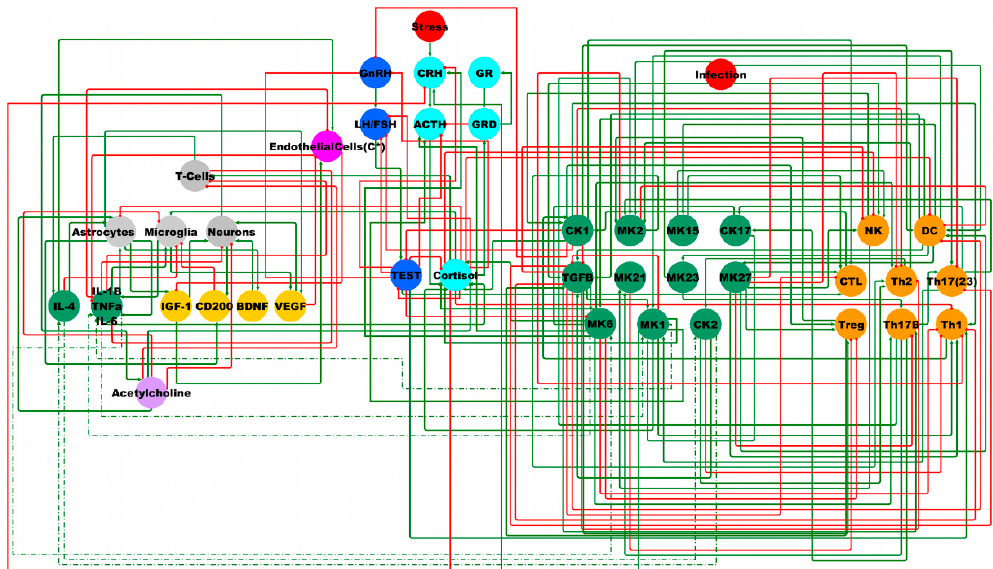
Figure 3. Theoretical male neuroimmune signaling network. Light blue nodes denote the HPA axis model described in [37]. Dark blue nodes denote the male HPG axis as described in [38]. Orange and green nodes on the right denote a system of immune signaling molecules and immune cells, respectively, as originally described in [39]. Grey, yellow, pink, purple, and green nodes on the left denote neuronal–glia interactions, growth factors, blood–brain barrier, neurotransmitter, and neuroimmune signaling molecules, respectively, as originally described in [53]. Red nodes denote external influences on the system. Green edges are stimulatory, and red edges are inhibitory.